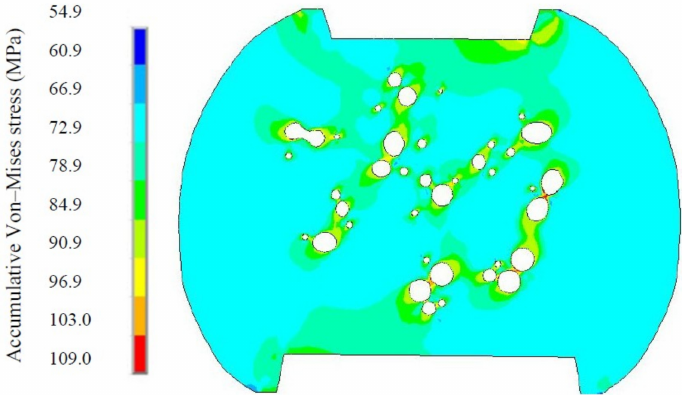
Figure 6. Accumulative Von-Mises stress contour of the micro-joint with adjacent and similar-size large Ag 3 Sn particles after eight TS